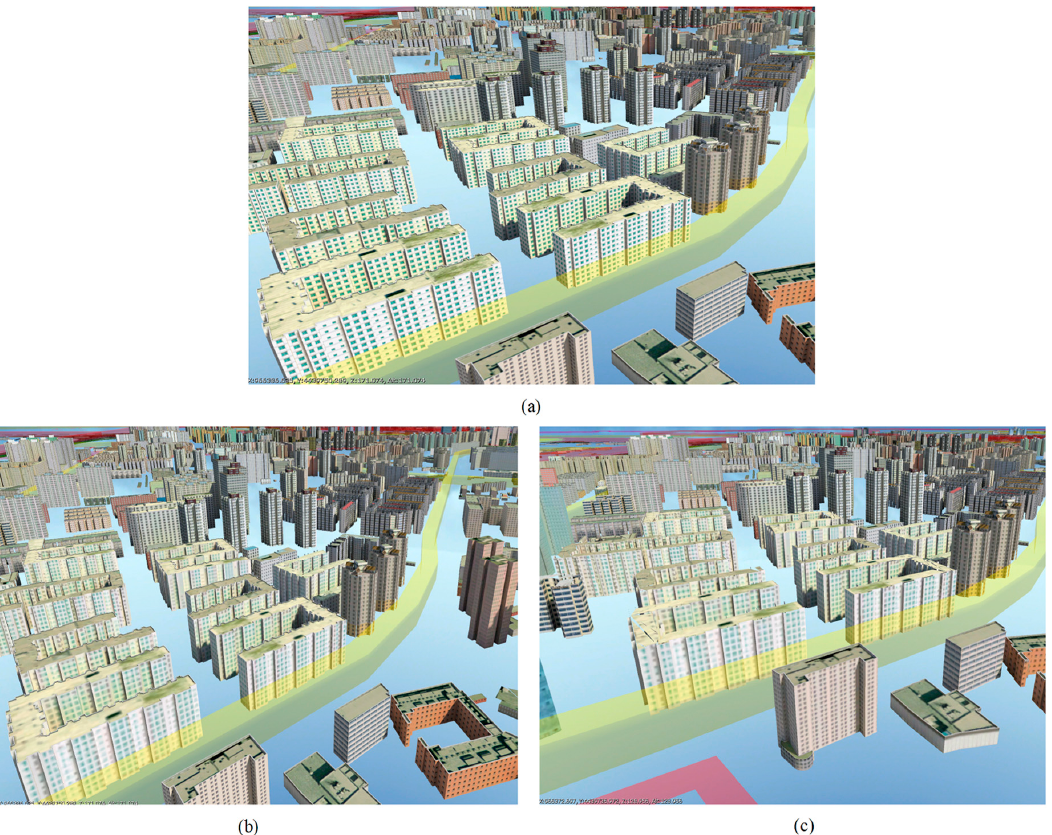
Figure 19. Building-LOD-model visualization with different screen pixels thresholds: ( a ) 60 pixels; ( b ) 120 pixels; ( c ) 400 pixels.